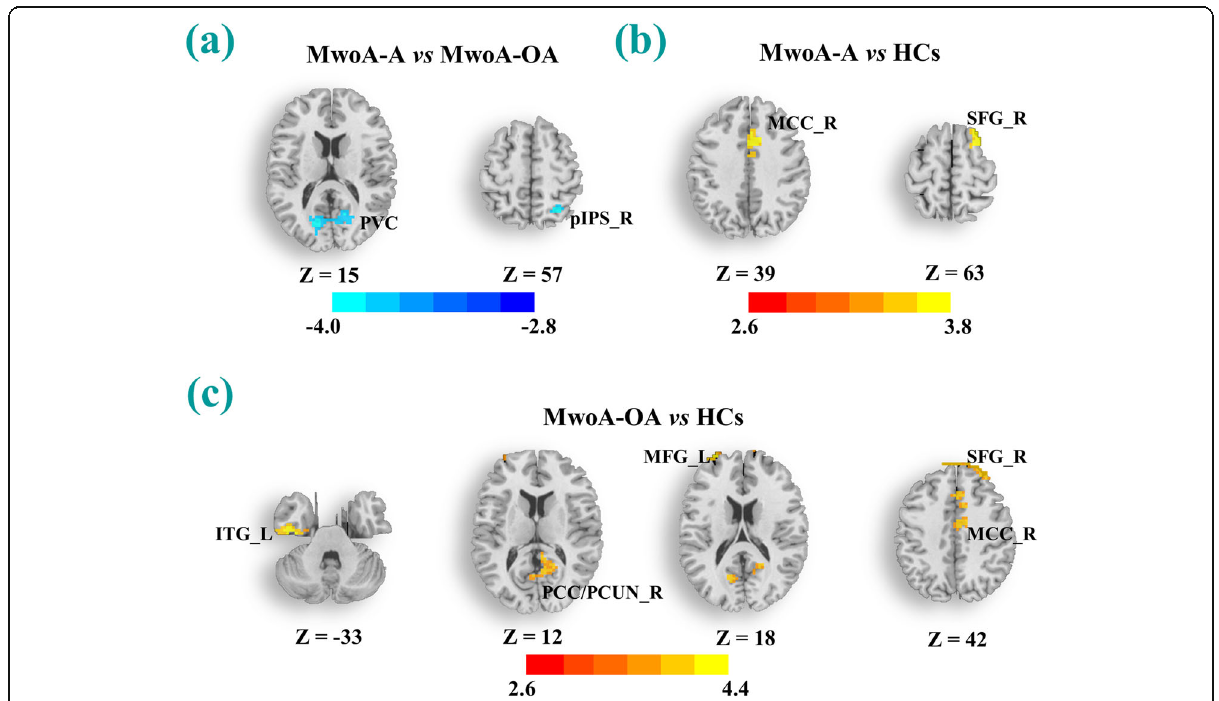
Fig. 2 a - c The brain regions showed significant group differences in functional connectivity based on the right LG among the three groups (MwoA-A, MwoA-OA and HCs). The significance threshold was set at voxel-level p < 0.005 ( Bonferroni corrected) with a 40-voxel extension. Cool color represents decreased strength of functional connectivity and warm color represent increased strength of functional connectivity.